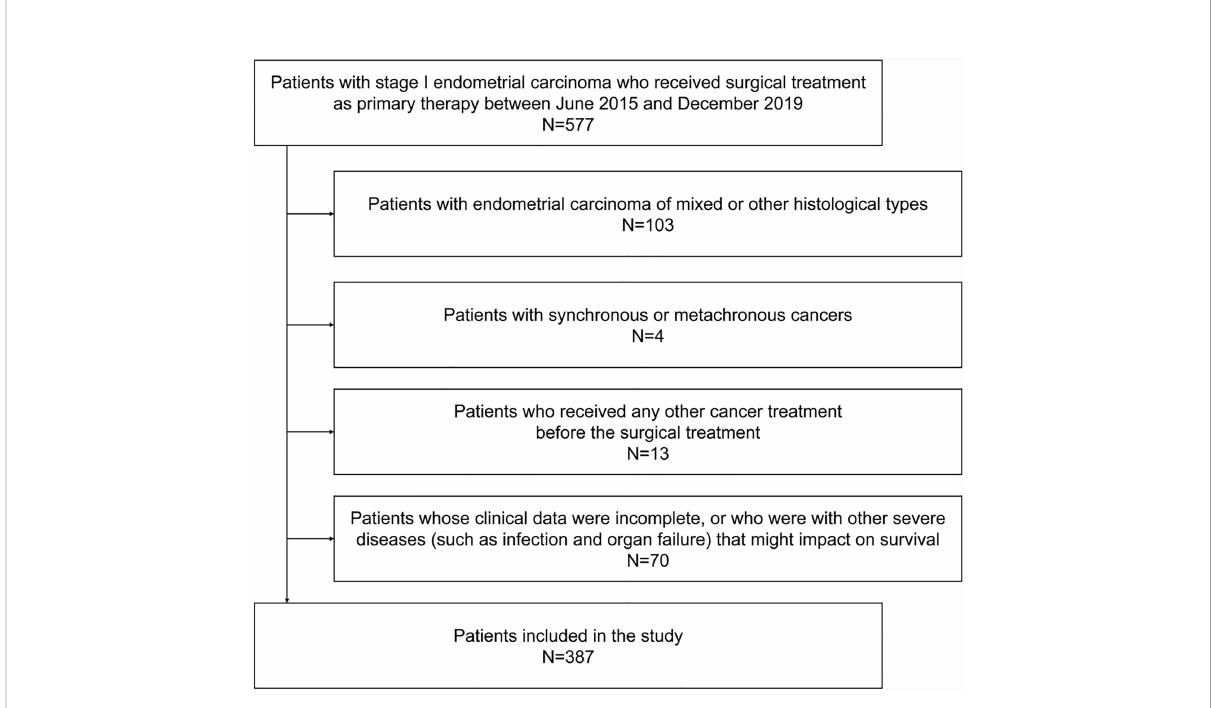
FIGURE 1 Flow graph for the inclusion of the study